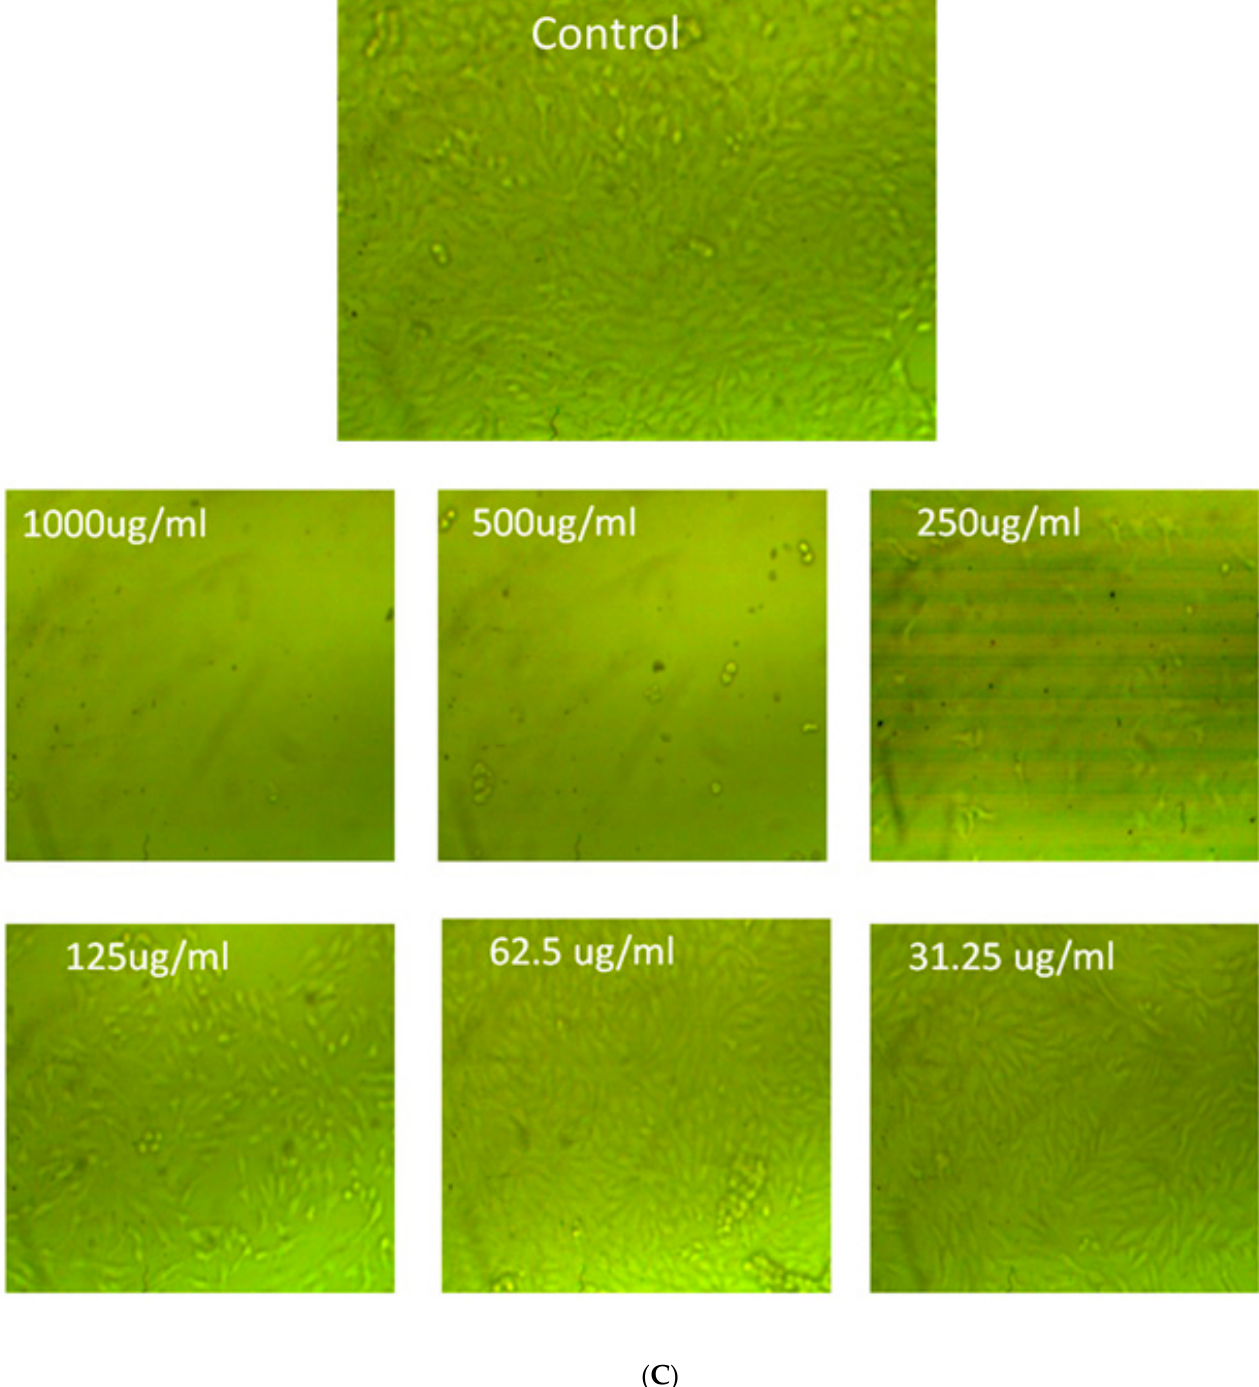
Figure 13. ( A ). Effect of purified chitinase by T. funiculosus strain CBS 129594 on MCF7 cells at different concentrations. ( B ). Effect of purified chitinase by T. funiculosus strain CBS 129594 on HCT 116 cells at different concentrations. ( C ). Effect of purified chitinase by T. funiculosus strain CBS 129594 on HepG2 cells at different concentrations.